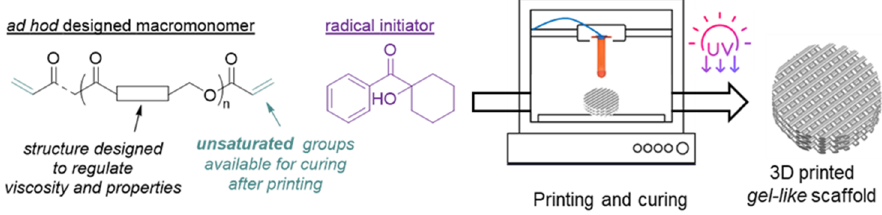
Figure 1. Overview of the approach.